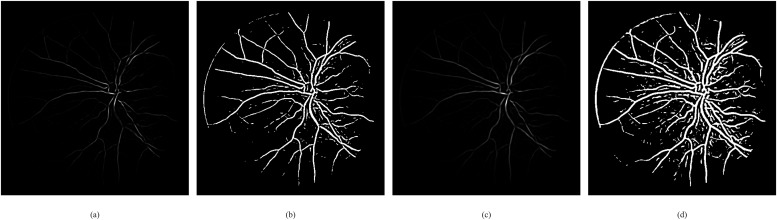
Analysis of Frangi filtering enhancement using DRIVE dataset.(a) Thin vessel enhanced image (b) Thin binary image (c) Thick vessel enhanced image (d) Thick binary image.